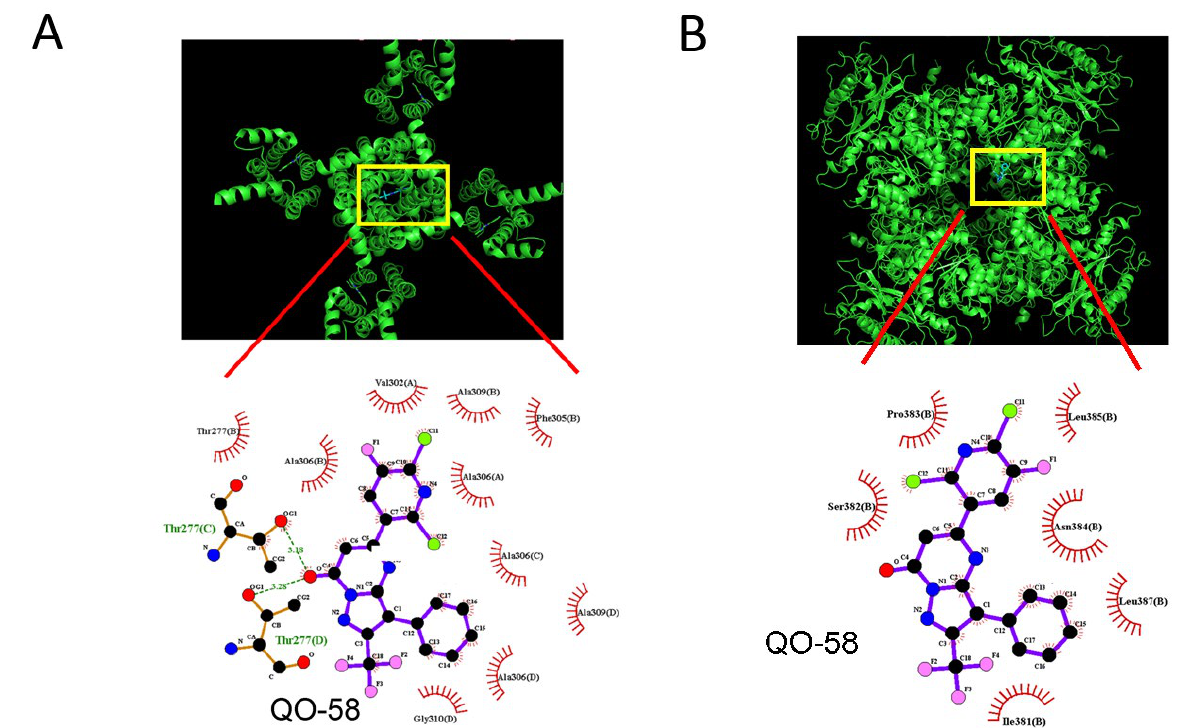
Figure 9. Docking results of K Ca 1.1 channel and QO-58 ( A ) or KCNQ2 and QO-58 ( B ). Protein structure of K Ca 1.1 or KCNQ2 channel was acquired from PDB (PDB ID: 6V3G or 7CR1), respectively, while chemical structure of QO-58 was from PubChem (Compound CID: 51351551). The structure of K Ca 1.1 or KCNQ2 channel was docked by the QO-58 molecule through PyRx (https://pyrx.sourceforge.io/, accessed on 23 June 2022). The diagram of interactions between K Ca 1.1 or KCNQ2 channel and the QO-58 molecule was generated by LigPlot + (https://www.ebi.ac.uk/thornton-srv/software/LIGPLOT/, accessed on 23 June 2022). Of note, the red arcs with spokes radiating toward the ligand (i.e., QO-58) in the lower part of each panel denote the hydrophobic contact, while green dot line indicates the hydrogen bond.